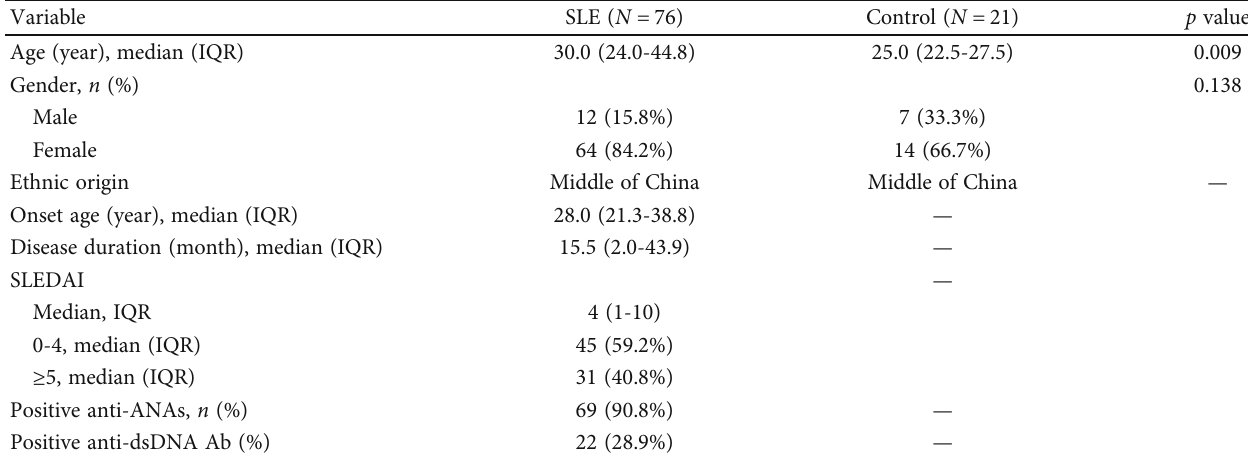
Table 1: General clinical characteristics of